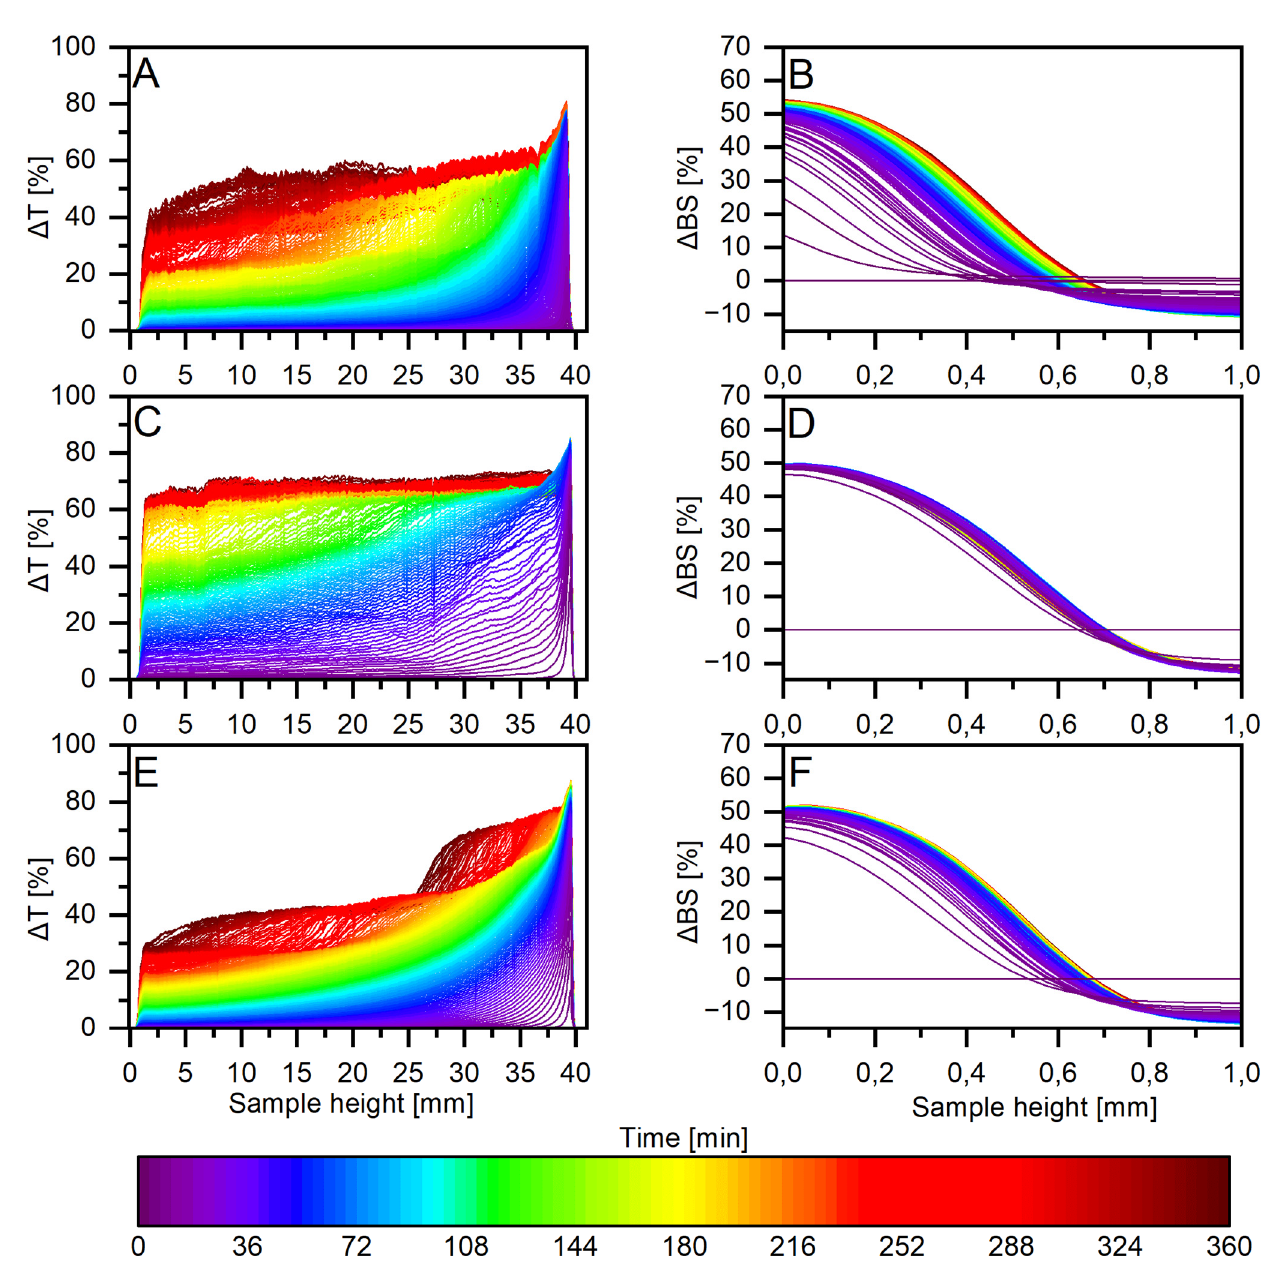
Figure 6. Transmittance profiles (( A ), control sample, ( C ), 50 mg · dm − 3 RL, ( E ), 100 mg · dm − 3 RL) and backscattering (( B ), control sample, ( D ), 50 mg · dm − 3 RL, ( F ), 100 mg · dm − 3 RL) for dolomite Table 1. Changes in TSI, calculated solid phase migration velocity and zeta potential values for different RL concentrations. TSI (A) after 60 min and TSI (B) after 180 min. The results correspond to the curves in Figures 7 and 8 accordingly.